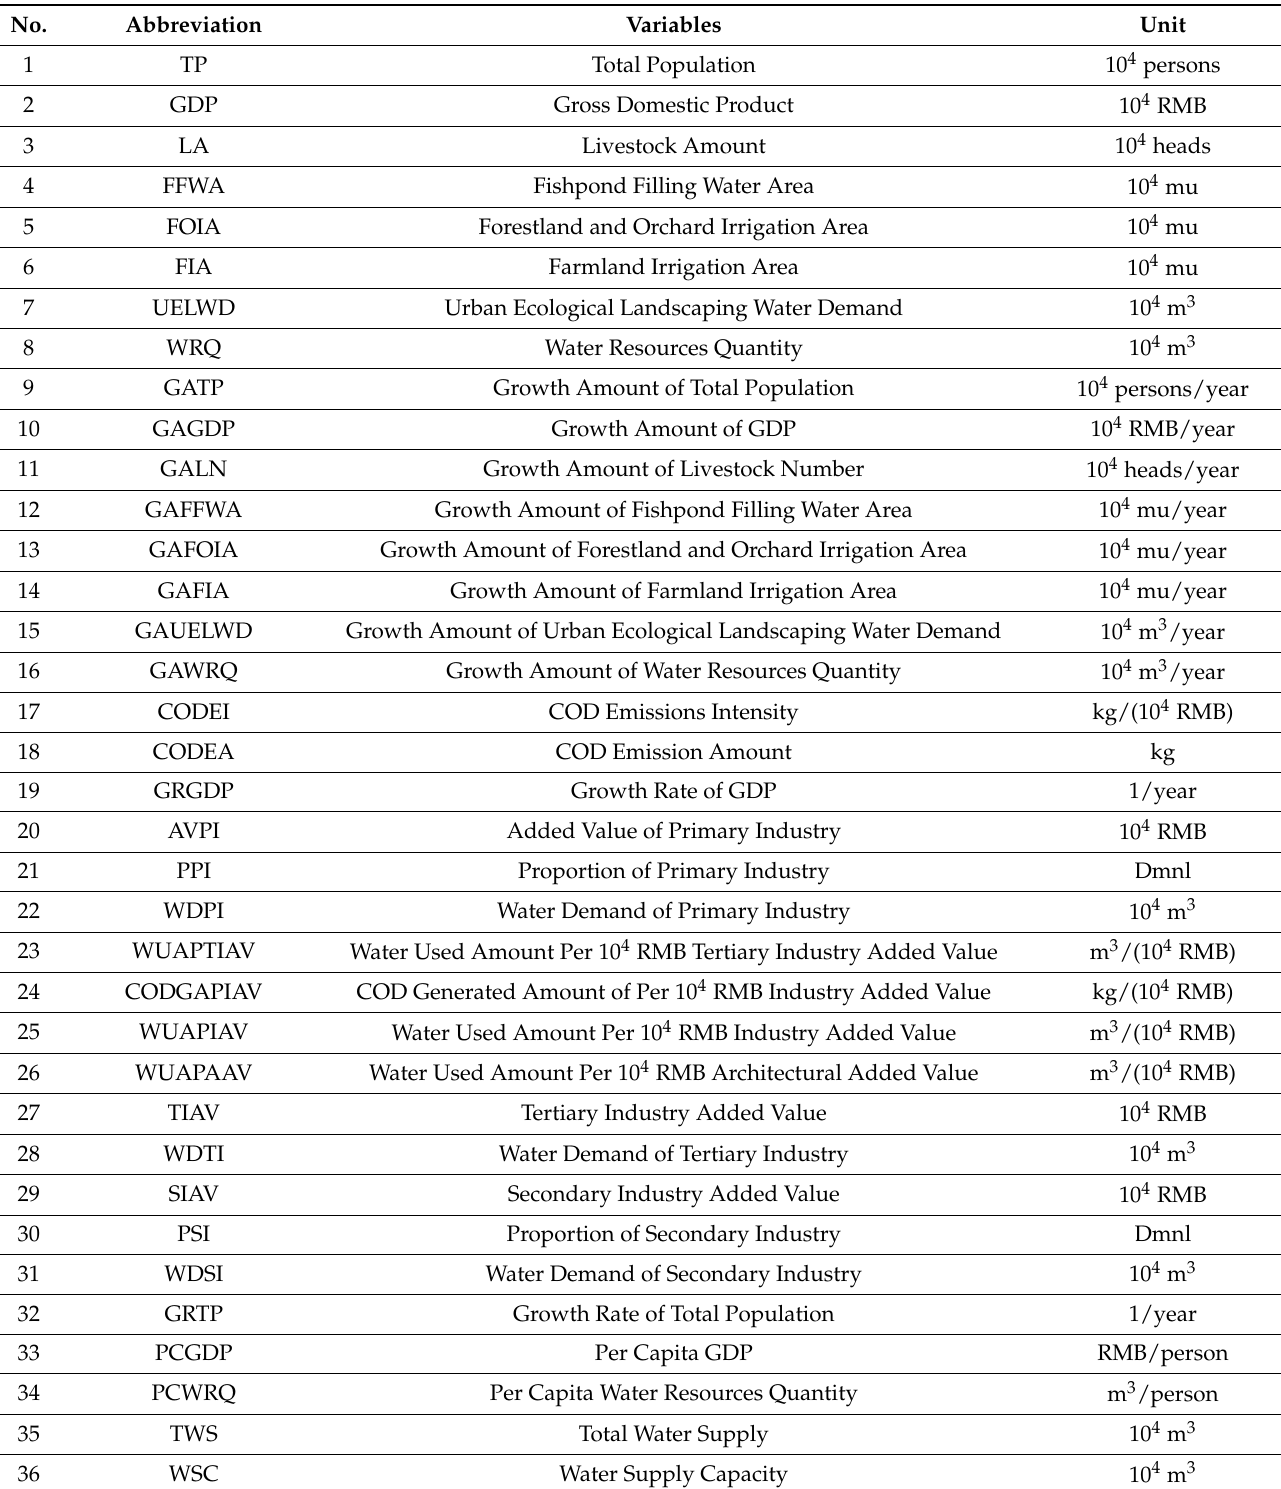
Table A1. Abbreviations for variables in the water resources system